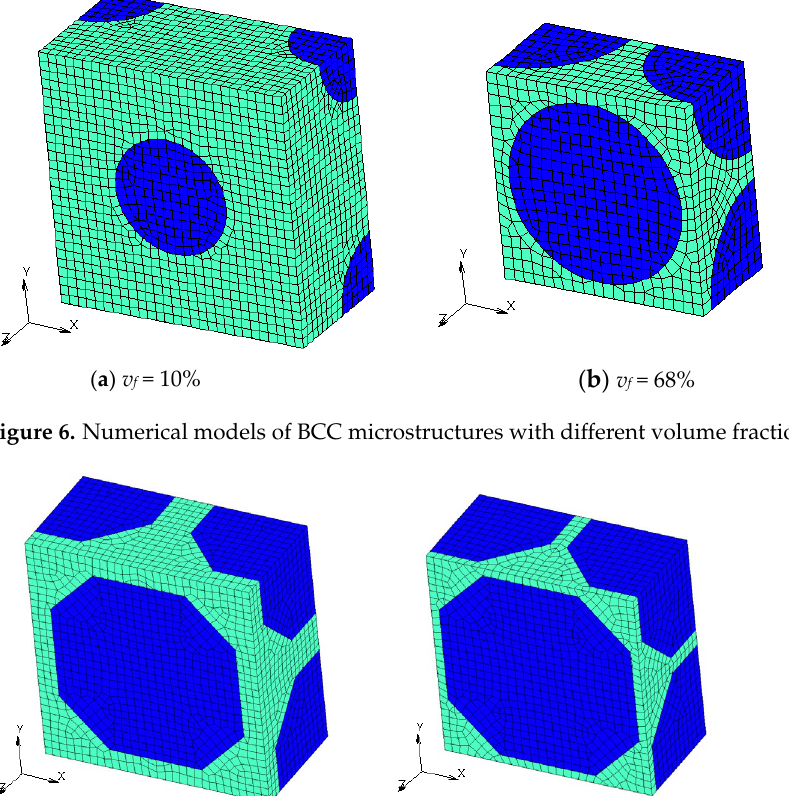
Figure 5. Numerical models of transformed FCC microstructures with different volume fractions.